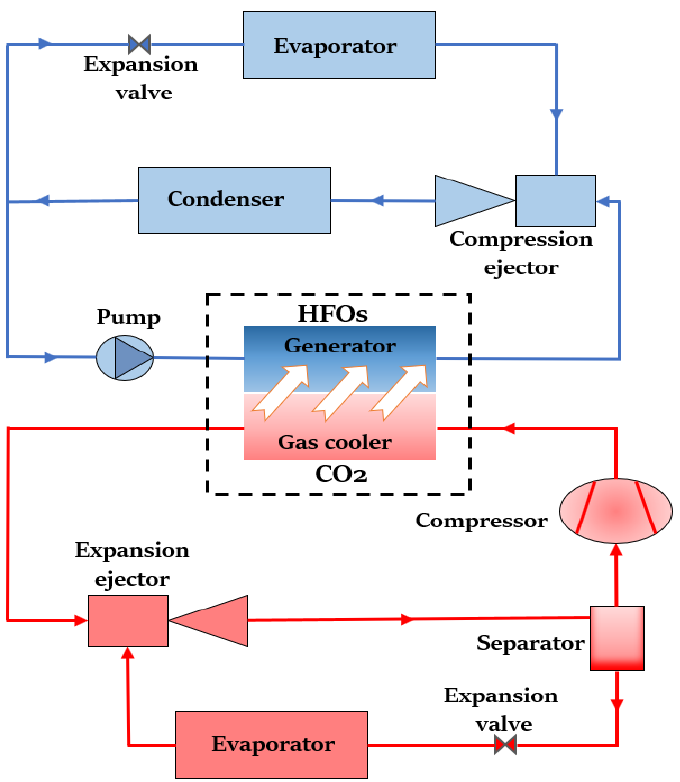
Figure 1. System diagram including the combined plate heat exchanger.